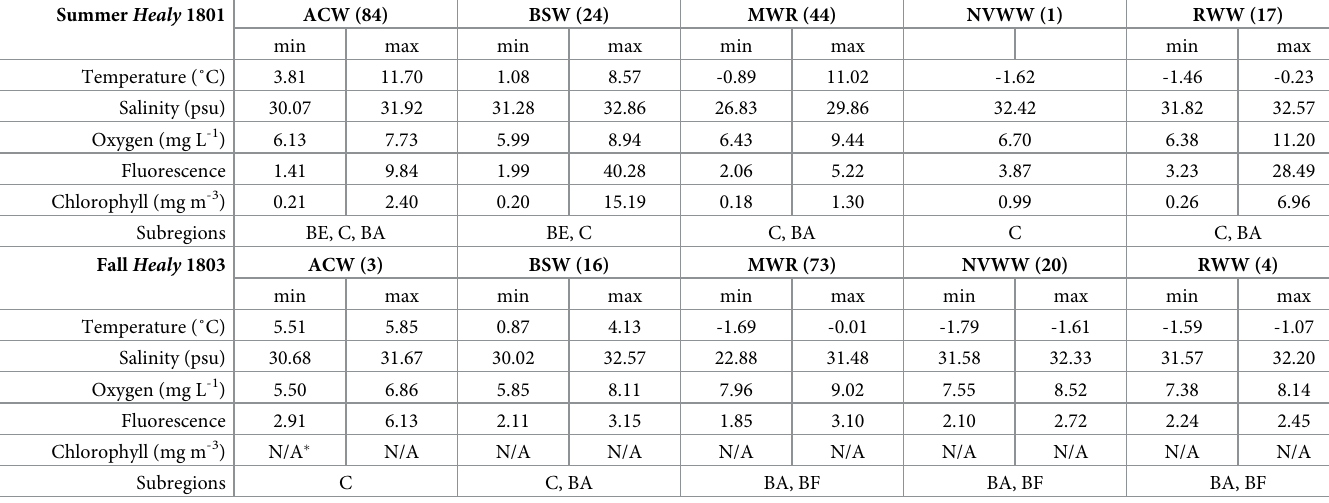
Table 2. Water mass characteristics during summer ( Healy 1801) and fall ( Healy 1803). Number of samples per cruise (in parentheses after water mass names), and minima (min) and maxima (max) for temperature, salinity, dissolved oxygen, and chlorophyll a are included. Summer Healy